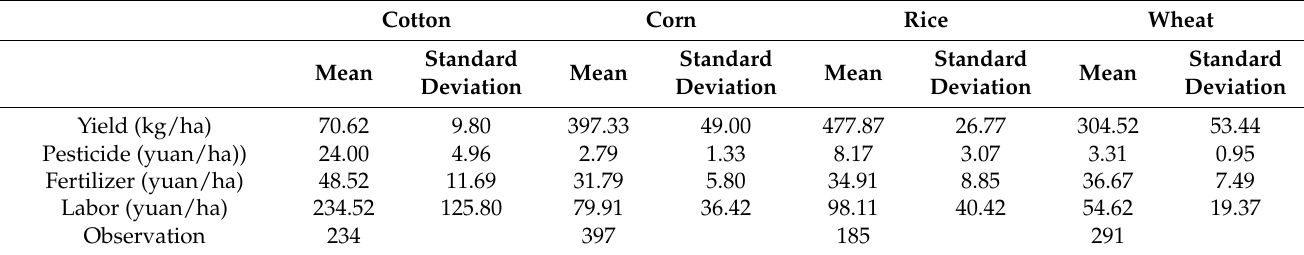
Table 2. Summary statistics of average inputs and output of cotton and three grain crops in China from 1990 to 2015. Cotton Corn Rice Wheat Standard Standard Standard Standard Mean Mean Deviation Deviation